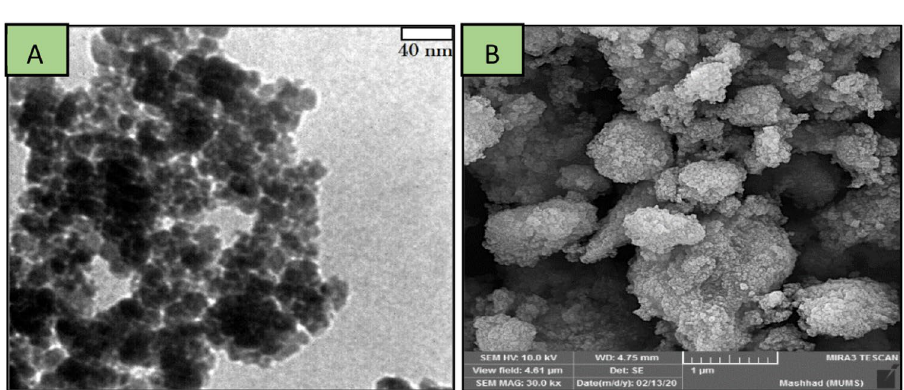
Figure 16. ( A ) TEM, and ( B ) FE − SEM, images recovered of the γ-Fe 2 O 3 @PEG@PAMAM G 0 -Cu complex after the 6th run for model reaction, reaction conditions: iodobenzene (1.00 mmol), phenylacetylene (1.5 mmol), NaOH (2.0 mmol), catalyst (0.8 mol% of Cu, 0.006 g), H 2 O (5.0 mL), 80